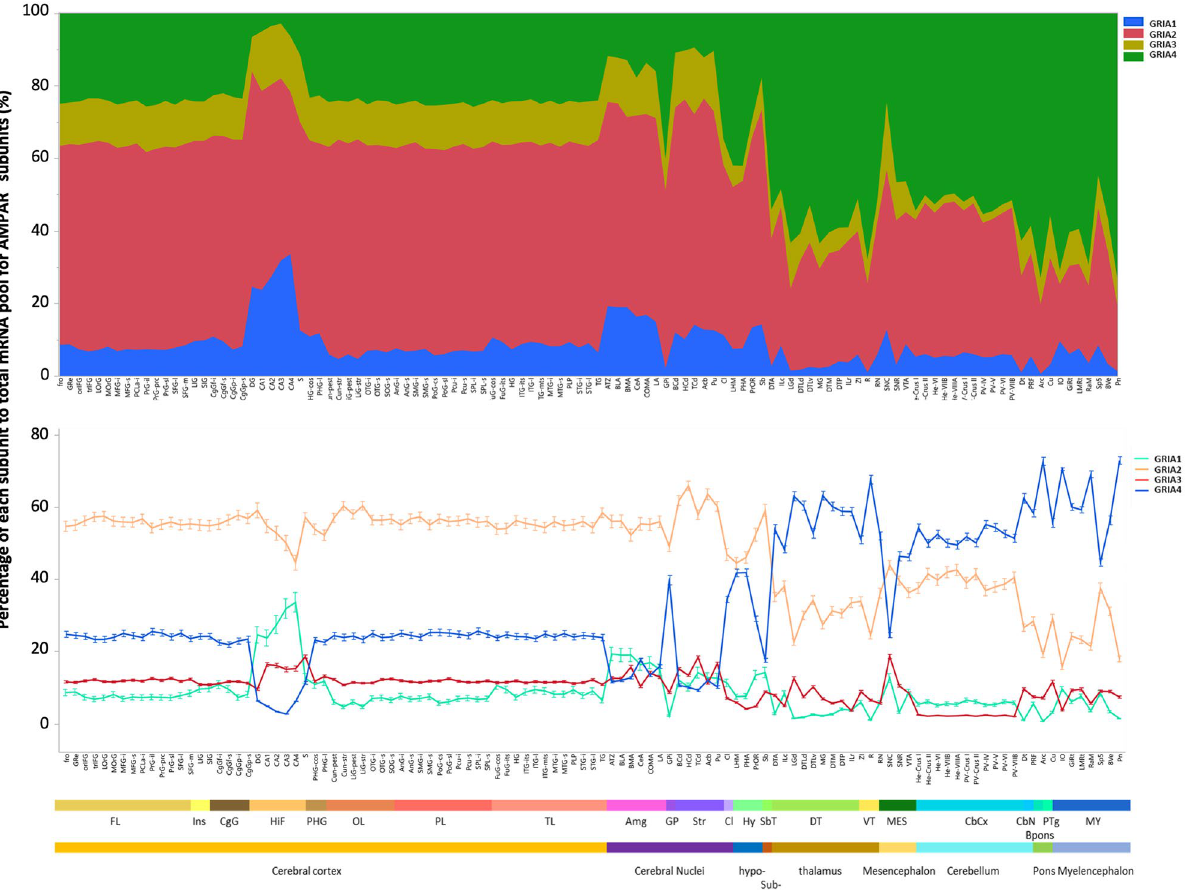
Figure 2. Region-specific proportional contribution of AMPAR subunits (GRIA1-4) across the brain. The area map graph (top) shows proportional contributions of each subunit as percentages to the total pool of AMPAR subunits in the brain. The line graph (bottom) of proportional contributions by each subunit more clearly shows interregional trends. (n = 6 subjects, 111 substructures) Structures are organized in a rostro-caudal order according to the Allen Brain Atlas. FL frontal lobe, Ins insula, CgG cingulate gyrus, HiF hippocampal formation, PHG parahippocampal gyrus, OL occipital lobe, PL parietal lobe, TL temporal lobe, Amg amigdala, GP